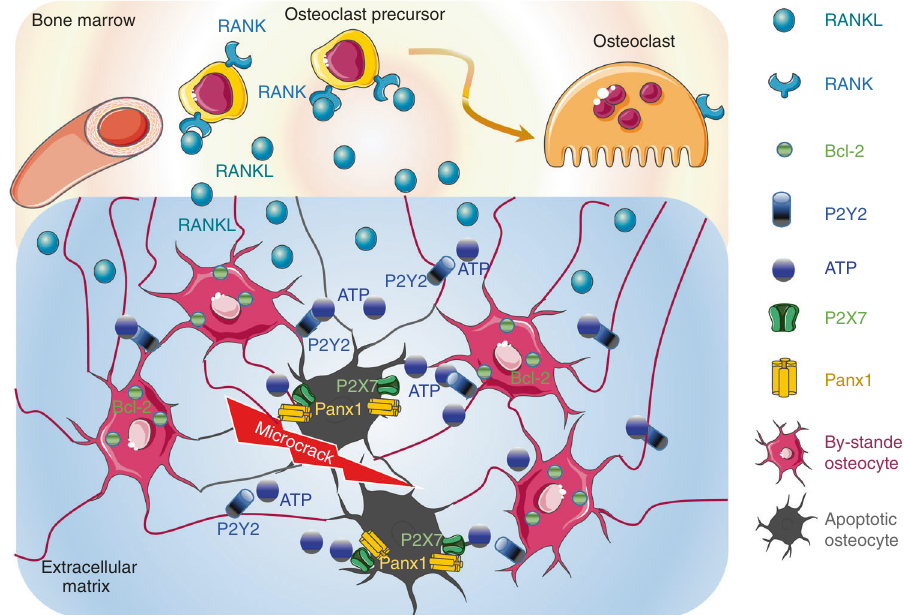
Fig. 2 The “ fi nd me ” message from apoptotic osteocytes. Under fatigue failure, osteocytes undergo apoptosis, whereas the osteocytes surrounding the apoptotic osteocytes, the “ bystander osteocytes ” , show upregulation of the antiapoptotic protein BcL-2, which protects them from death. Apoptotic osteocytes activate the Panx1/P2XR pathway to induce the release of ATP into the extracellular compartment as a speci fi c “ fi nd me ” signal. ATP binds P2Y2 receptors on bystander osteocytes, which in turn produce and release RANKL at the interface with the bone marrow. RANKL promotes the recruitment of osteoclast progenitors and